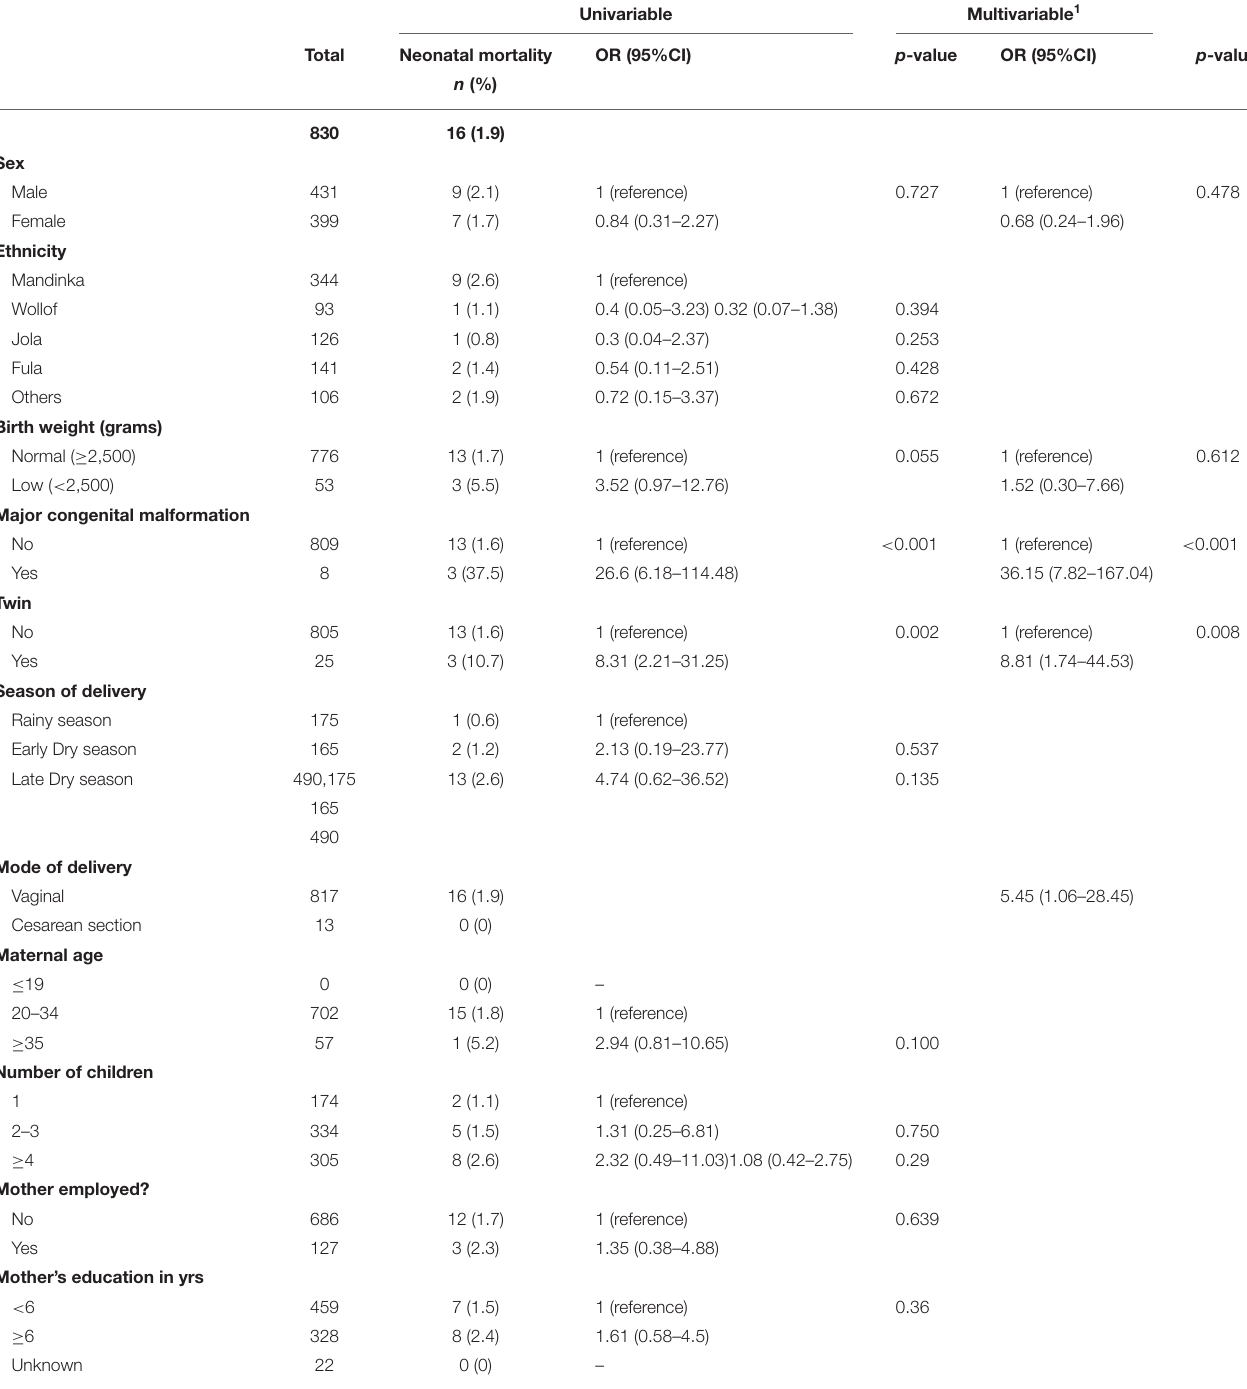
TABLE 3 | Risk factors of death during the study period (0–56 days) ( N = 829 live